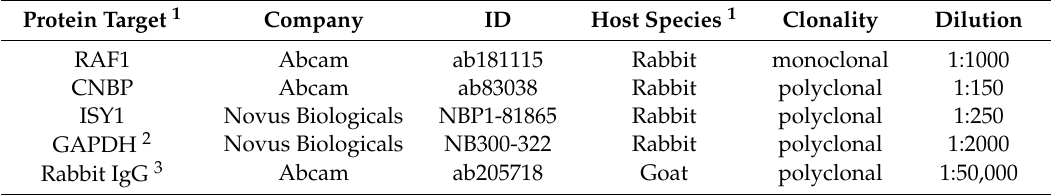
Table 2. Details for the primary and secondary antibodies used for Western blotting to detect protein expression among wg-2 genotypes from expressed genes of the 227-kb candidate region on GGA 12.